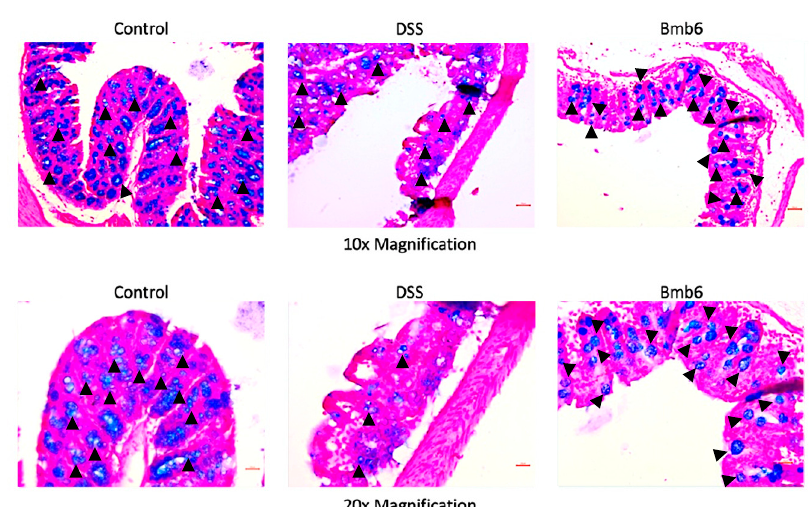
Figure 5. Hematoxylin-eosin staining of colon sections in DSS-induced colitis mice. The DSS group showed an intensive loss of intact epithelial structure (arrow) and infiltration of immune cells (arrowhead); the Bmb6 group showed slight epithelial structural damage (arrow) and infiltration of immune cells (arrowhead). Scale bar = 50 μ m for 10× magnification; scale bar = 25 μ m for 20× magnification.